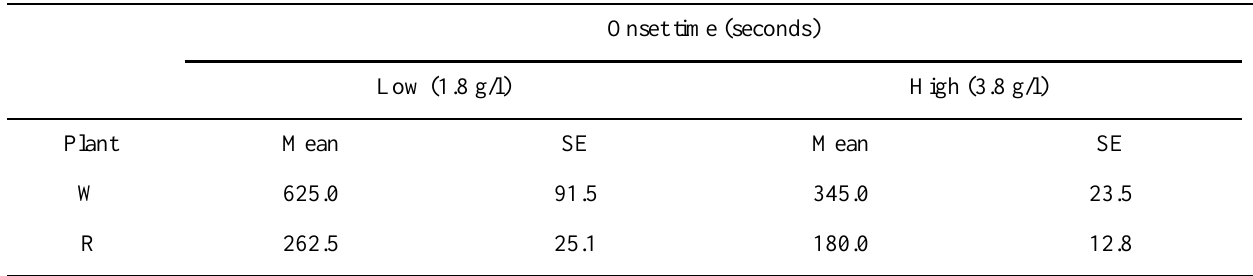
Table 1. Mean onset time for the two treatment concentrations of W and